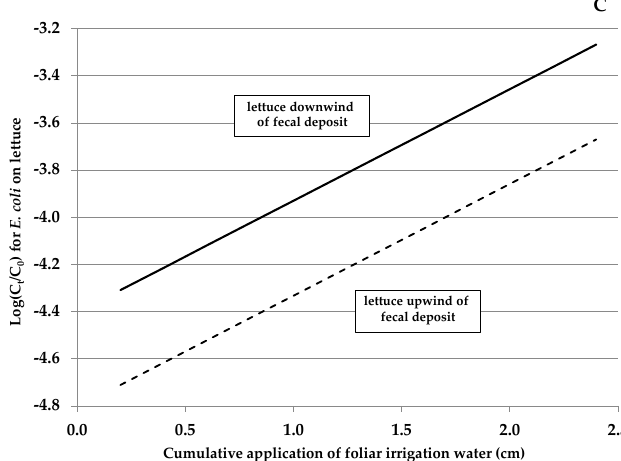
Figure 2. The predicted effect of ( A ) mean distance from the four closest sprinklers to the fecal deposit, ( B ) distance between head of lettuce and the fecal deposit, and ( C ) cumulative application of foliar irrigation on log(C t / C o ). C t represents the predicted bacterial concentration per head of lettuce under the stated conditions based on the negative binomial regression model shown in Table 2, and C o is the mean number of inoculated E. coli Rif r per 5 g of chicken or rabbit feces (4.825 × 10 8 MPN). Table 1. Experiment A. Mean concentration of E. coli Rif r in 5 g of chicken and rabbit feces placed in 287 the furrow up to four days prior to irrigation day (day 0) compared to E. coli Rif r concentrations 288 measured immediately after irrigation. 289